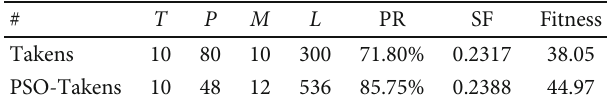
Table 2: Parameter changes of knee joint prediction algorithm under nonstandard gait